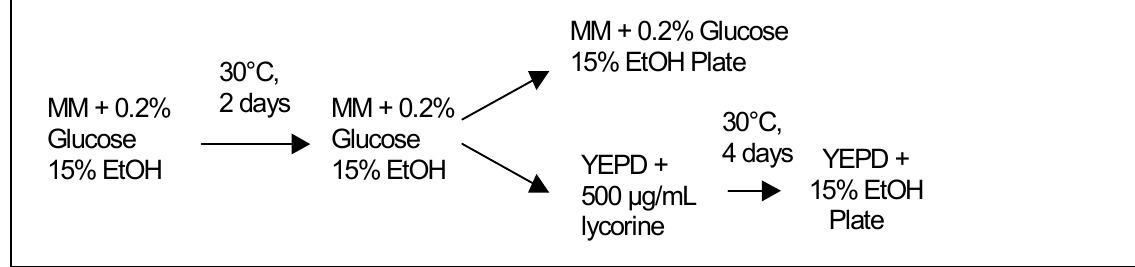
Figure 2. Flow chart showing the culture method of using ethanol to induce yeast